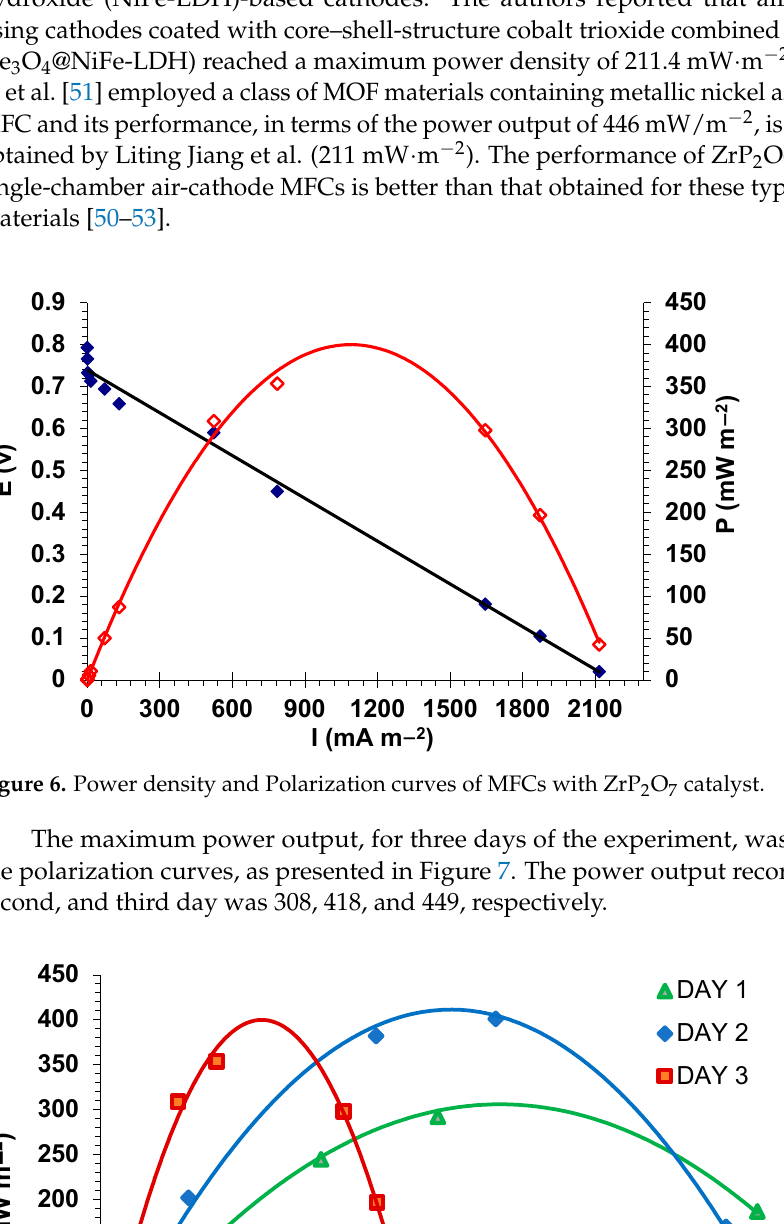
Table 2. max power and internal resistance of the studied system per day. Day